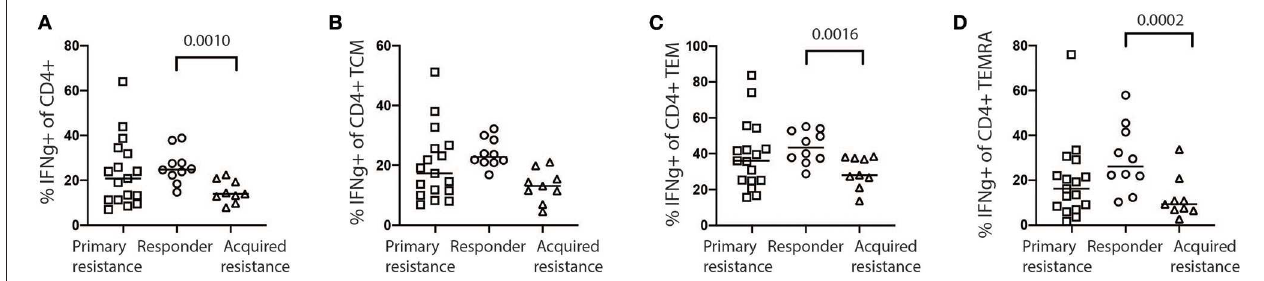
FIGURE 7 | Expression of IFN γ by stimulated baseline samples. (A) Comparison of primary resistance, responder, and acquired resistance groups revealed production by a significantly higher proportion of total CD4T cells within the responder group, compared with the acquired resistance group, however not significant within the CD4 T cell CM compartments (B) . The difference was also statistically significant within the CD4T cell EM (C) and TEMRA (D) compartments. The statistical differences were analyzed using a Kruskall-Wallis multiple comparisons